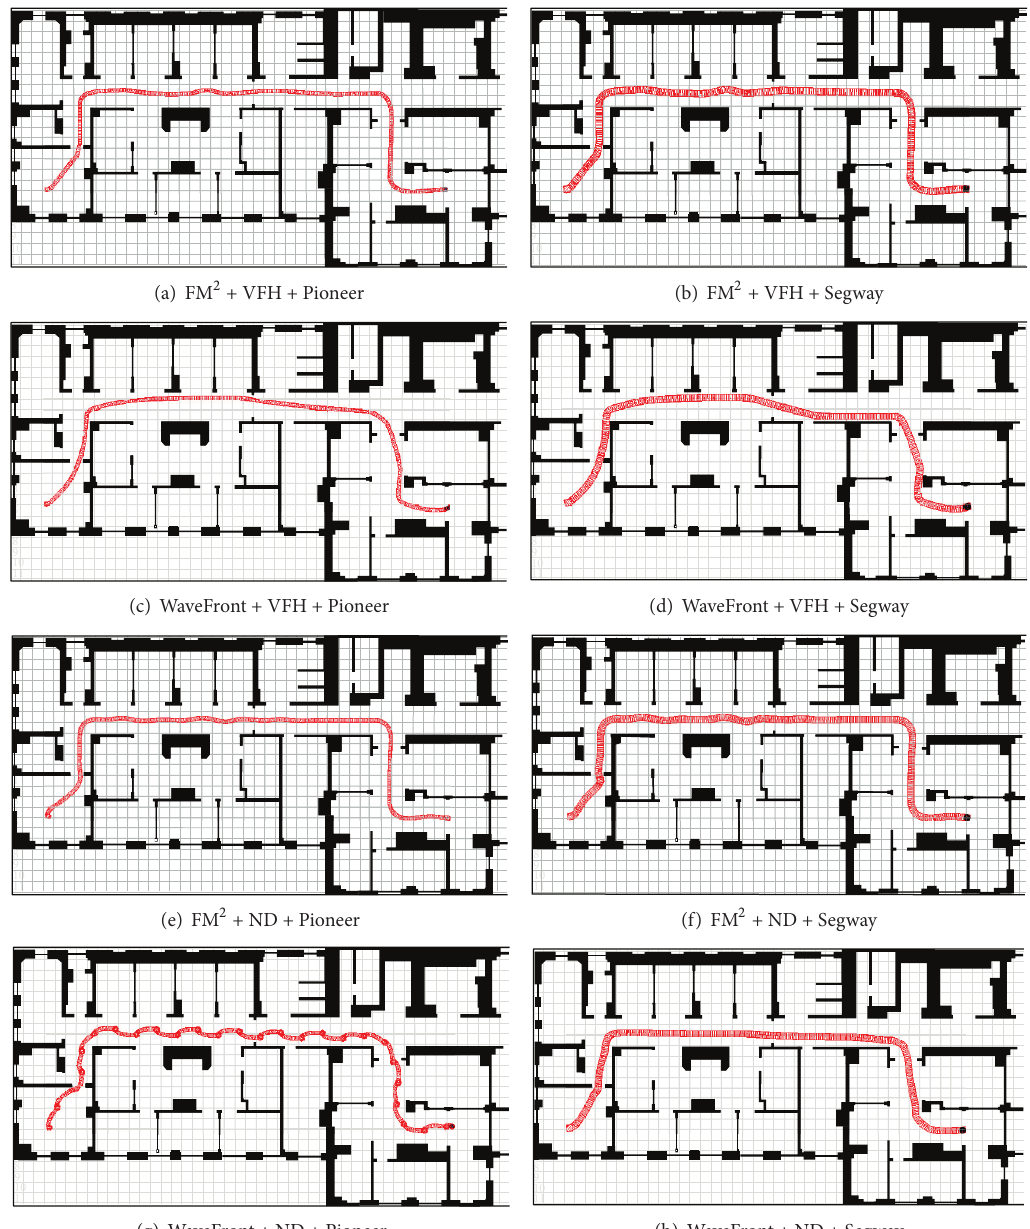
Figure 2: Hospital: examples of performed trajectories.